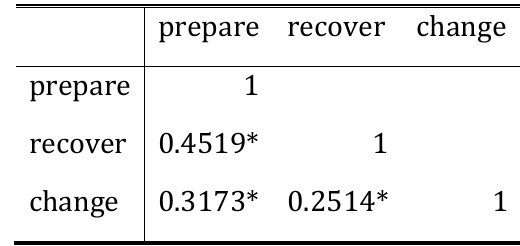
Fig. A1.4. Spearman correlations between key measures of subjective resilience.